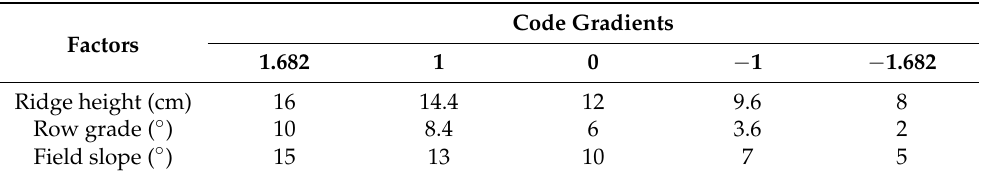
Table 1. Code gradients of ridge height, row grade, and field slope determined by an orthogonal rotatable central composite design and corresponding factors values.